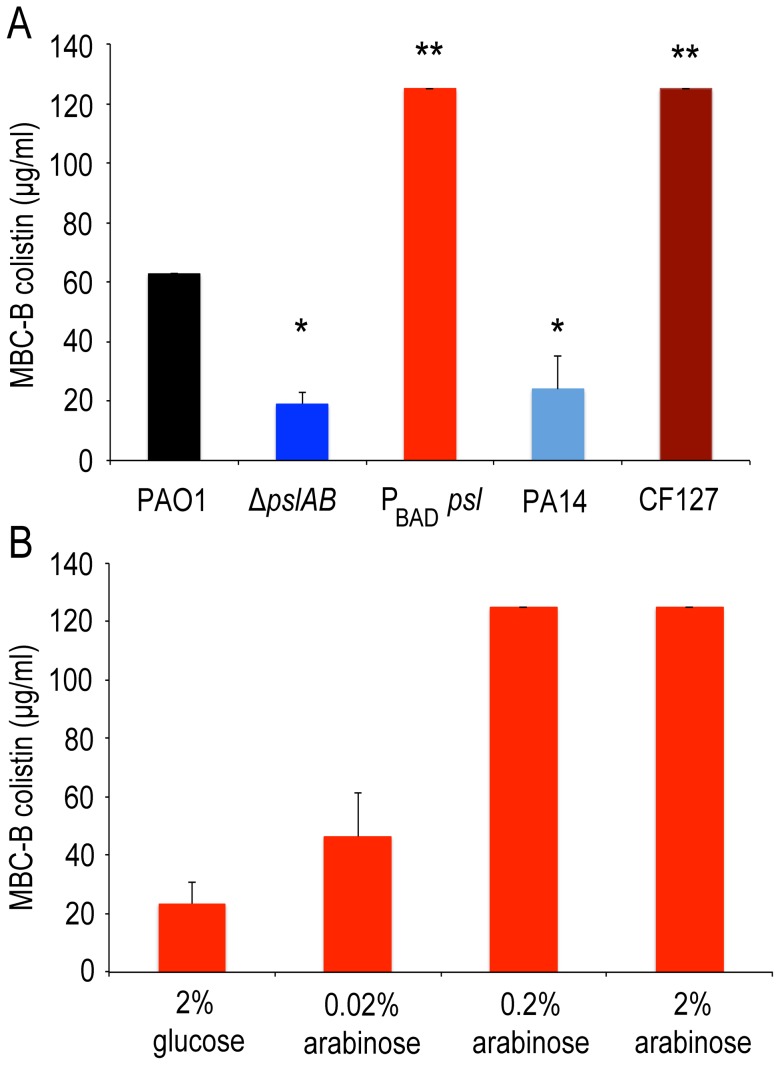
Over-expression of psl increases biofilm tolerance to colistin.Opposite to ΔpslAB, Psl over-producing strain P
BAD-
psl shows increased tolerance to colistin. (A) Strains that naturally lack (PA14) and over-express Psl (CF127) have similar sensitivities as the synthetic ΔpslAB and P
BAD-
psl, respectively. (B) Since Psl production was directly controllable in the over-producing strain by modulating the amount of the inducer (arabinose) in the culture medium, we could determine if tolerance correlated to the levels of Psl in the biofilm matrix. Biofilms that were formed in the presence of glucose tightly inhibited the expression of P
BAD-
psl, which resulted in increased sensitivity to colistin similar to ΔpslAB. For the data presented, shades of blue represent strains that do not produce Psl while shades of red represent strains that over-produce Psl. (*) indicates a significantly lower bactericidal antibiotic concentration and (**) indicates a significantly higher bactericidal antibiotic concentration when compared to WT PAO1 as determined by a student's t-test (P<0.05). Error bars represent SEM (n = 3).